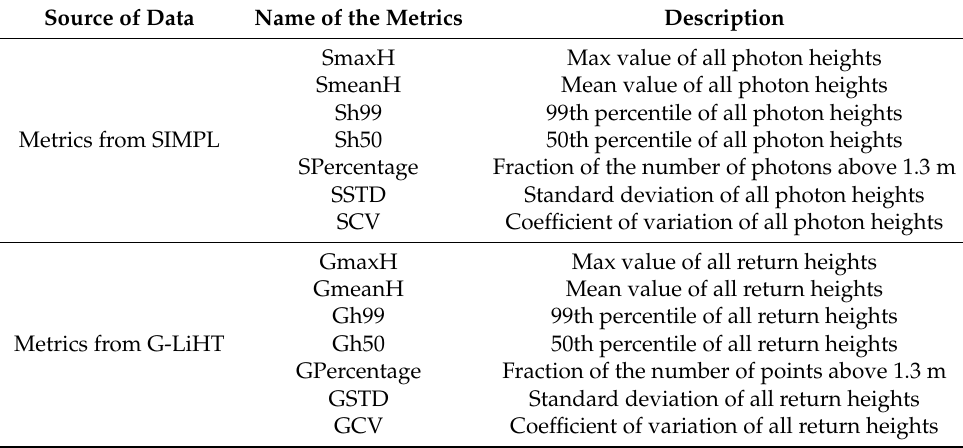
Table 2. Height metrics from SIMPL and